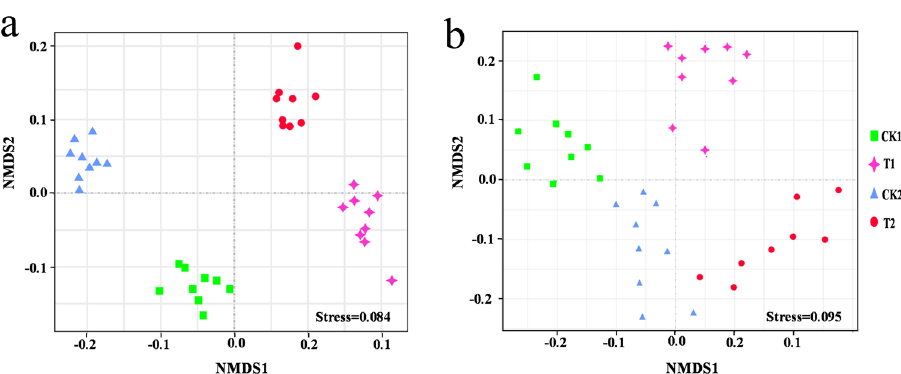
Figure 4. Non-metric multidimensional scaling (NMDS) according to the Euclidean distance plot of bacterial ( a ) and fungal ( b ) microbiota in the flowering stage (CK1 and T1) and fruiting stage (CK2 and